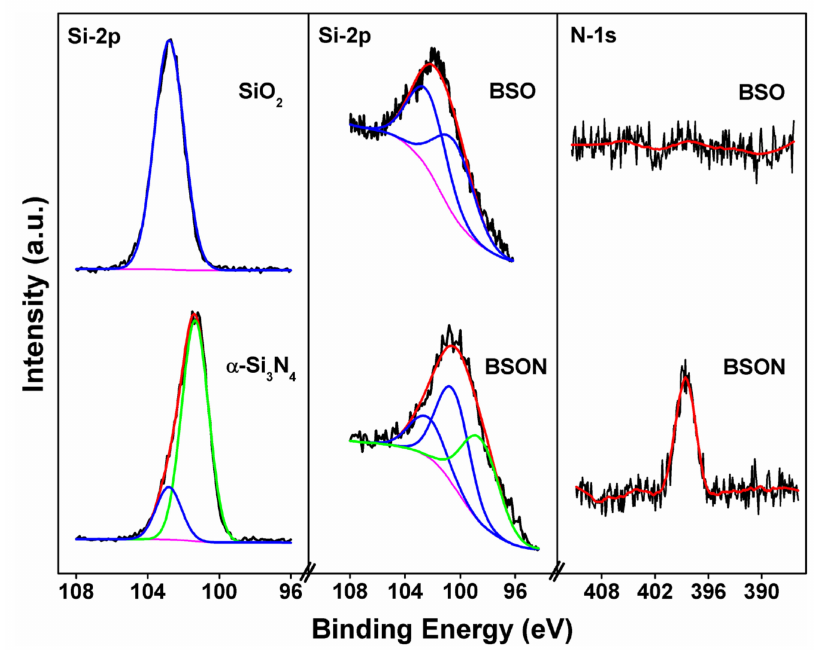
Figure 6. Si-2p and N-1s X-ray photoelectron spectroscopy (XPS) spectra of SiO 2 , α -Si 3 N 4 , BSO, and BSON